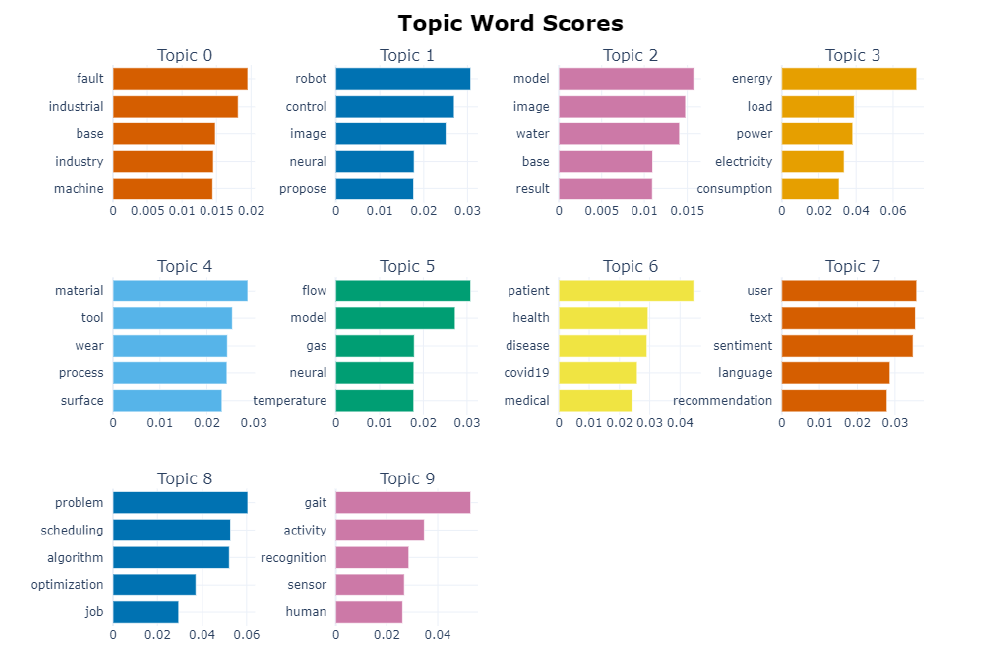
Figure 5. Plots of topic words by c-TF-IDF scores from topic modelling entire corpus.